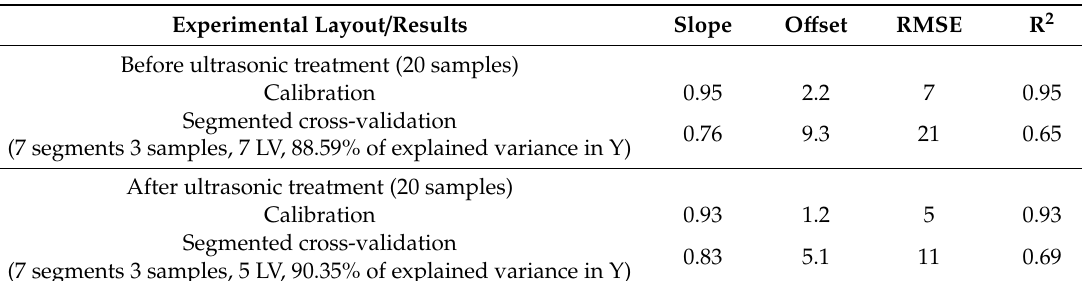
Table 2. The parameters of the “measured vs. predicted” plots for partial least squares (PLS) regression models predicting water toxicity in terms of Daphnia magna (death rate 0–100%) from the multisensor system